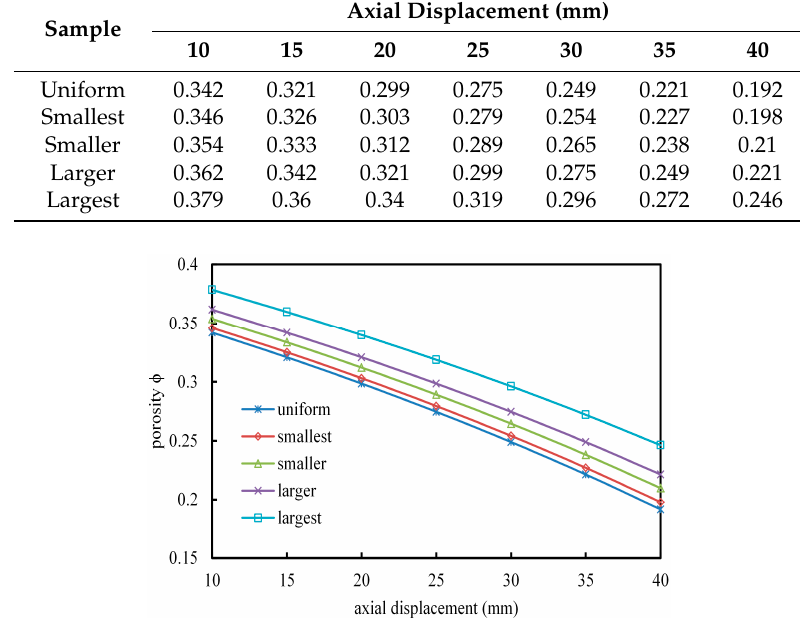
Table 2. Porosity evolution during compaction.